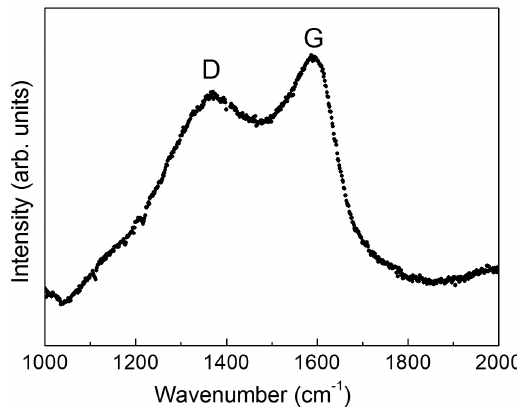
Figure 8. Raman spectrum of nanofibers deposited at 79 mTorr C H (sample 2 2